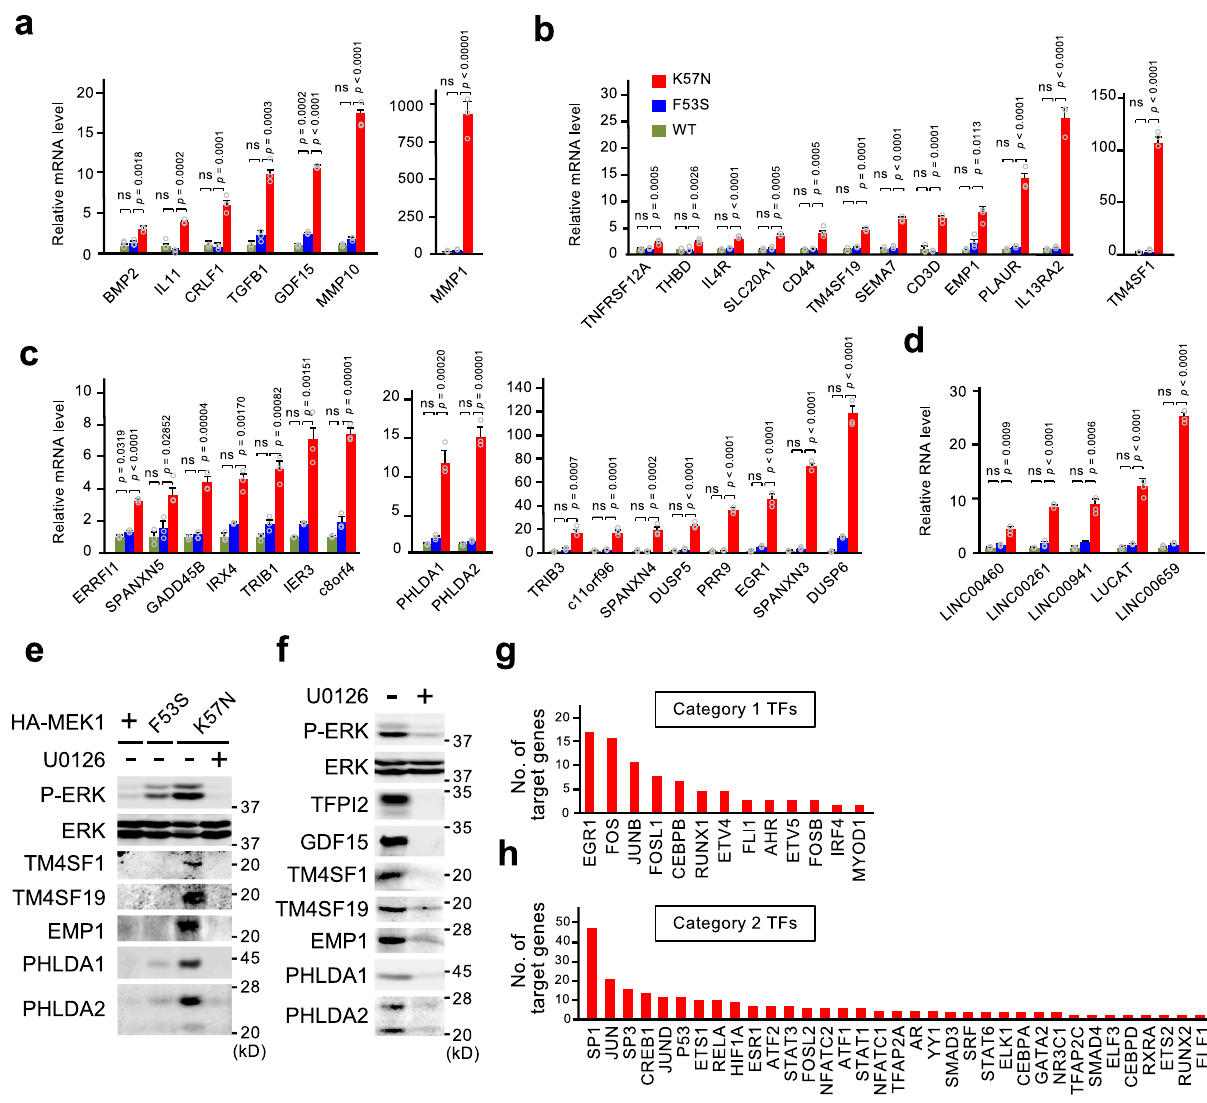
Fig. 6 Genes upregulated by oncogenic MEK1(K57N) serve as cancer signature genes. a – d qRT-PCR analyses of the sigmoidal-B group of genes. The genes were classi fi ed as encoding secreted ( a ), transmembrane ( b ), or cytoplasmic/nuclear ( c ) proteins, or long intergenic non-coding RNAs (lncRNAs) ( d ). Data are mean ± SEM from three independent experiments. P -values were assessed using one-way ANOVA followed by Tukey ’ s multiple comparisons test. ns, not signi fi cant. e , f The expression levels of the indicated proteins in HEK293 cells expressing HA-MEK1(WT, F53S, or K57N) ( e ) and in H1299 cells ( f ) were assessed by immunoblotting with the appropriate Abs. Where indicated, the cells were pretreated with the MEK inhibitor U0126 for 24 h. g , h TransFac analysis of the promoter regions of the genes upregulated (>2-fold, p < 0.05) in K57N cells. The graphs show the number of target genes of the transcription factors (TFs) that are increased (>2-fold) in expression ( g ) and of the TFs that show no or weak change (0.5- to 2-fold) in expression ( h ) vs. control cells. Source data are provided as a Source Data fi